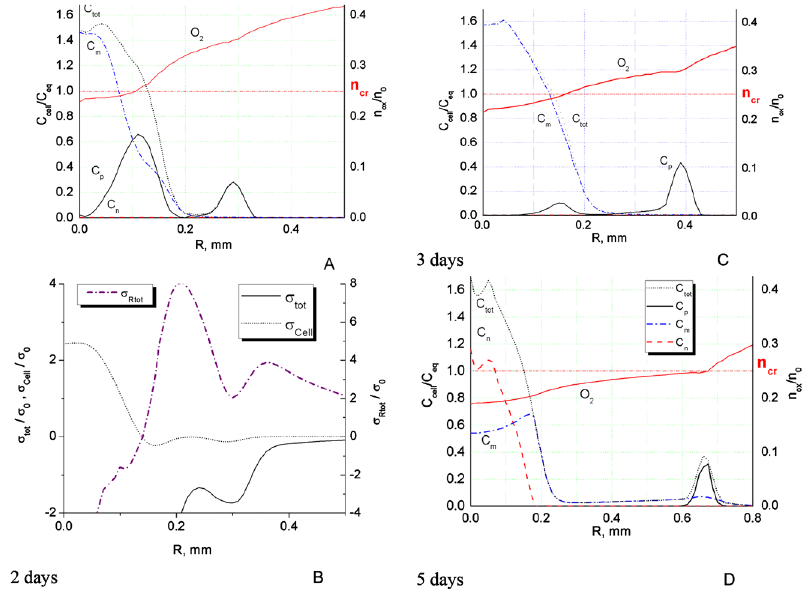
Figure 8: Formation of subtumor. Calculation results presented for days 2, 3, 5 of MTS growth at elevated matrix stiffness E ECM =2.5kPa andPSBC.Thegraphsshow radialcelldensitydistributions(A,C,D):forproliferativecells C C n and total cell density tot ; also the distribution of oxygen concentration is shown on these graphs; the dashed line showsthethresholdlevelofcellphenotypetransitionproliferative-to-hypoxic, n 0 =4mg/L;(B)showsstressdistributionforday2 including total stress in cells – ECM composite σ tot , intercellular stress distribution σ cell and radial component of the total stress σ Rtot